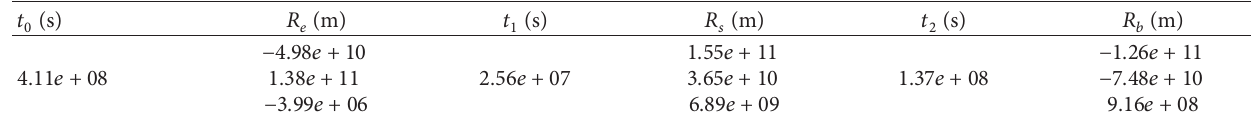
Table 2: 𝑡 0 , 𝑡 1 ,𝑡 2 and corresponding vectors 𝑅 𝑒 , 𝑅 𝑠 , and 𝑅 𝑏 .